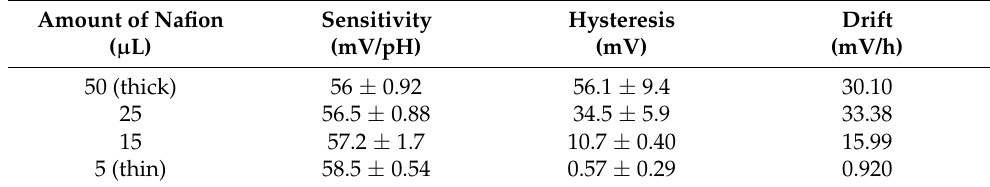
Table 2. Nafion thickness investigation using optimized annealing time of 25 min and temperature of 150 ◦ C as determined in Table